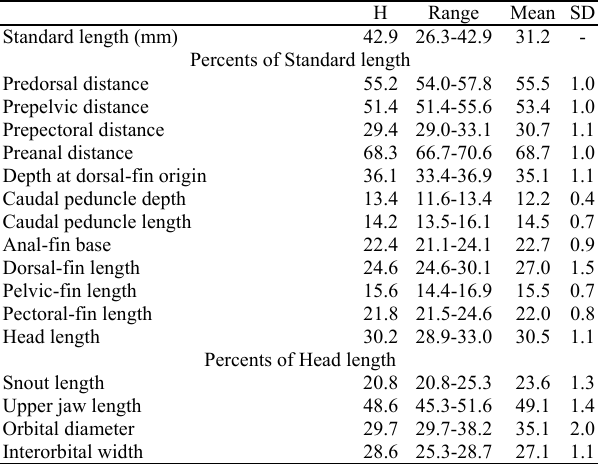
Table 1. Morphometric data for holotype and 15 paratypes of Moenkhausia dasalmas from the upper rio Tocantins basin. The range includes the holotype. SD = Standard